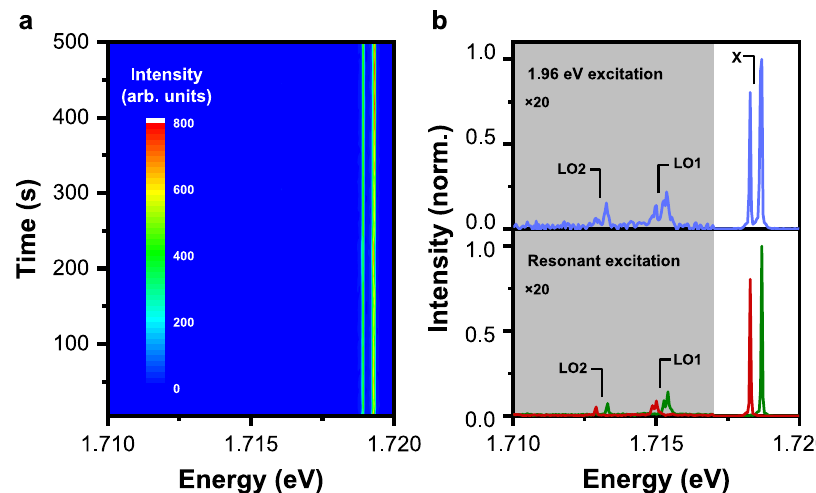
Fig. 1 Fundamental optical properties of a single CsPbI 3 NC. a Time-dependent PL spectral image constructed from 100 PL spectra each acquired with an integration time of 5 s under the 1.96 eV laser excitation. b (top panel) PL spectrum plotted by summing over the 100 PL spectra used in a to construct the image. (bottom panel) Two PL spectra measured with the laser excitation energies being resonant with the higher- and lower-energy PL peaks, respectively, both using an integration time of 1 s. In b , PL intensities in the shaded areas are magni fi ed by 20 times, while X and LO1/LO2 denote the single-exciton doublet peaks and the two longitudinal-optical phonon modes,